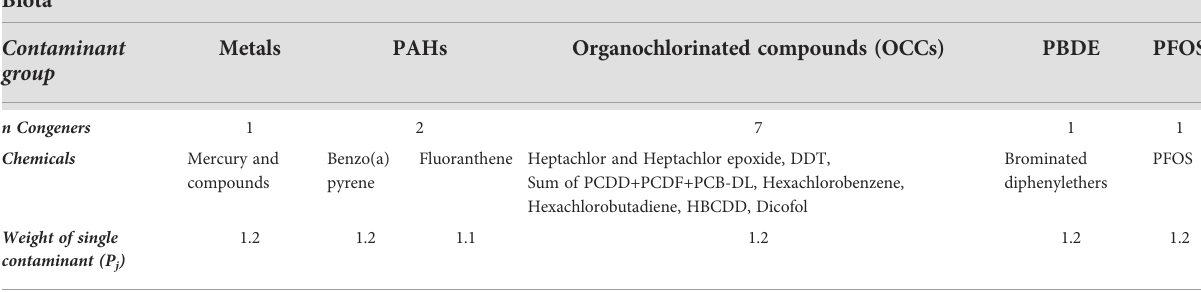
TABLE 3 Contaminants monitored in biota and weight of single contaminant.